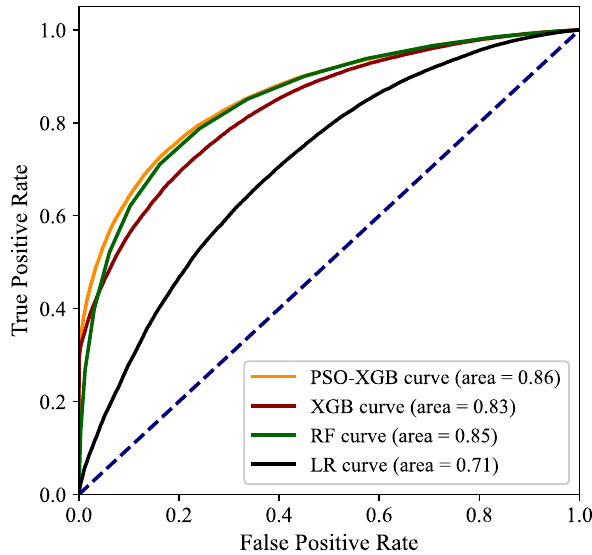
Fig. 9 ROC curves of compared models